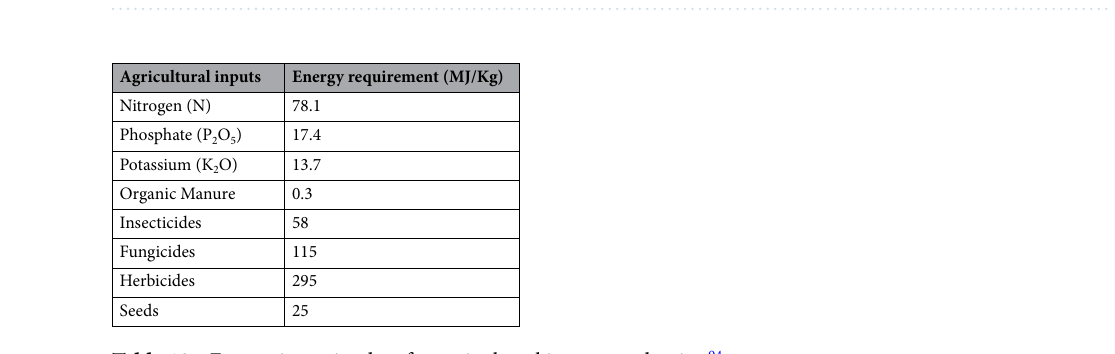
Table 18. Energy intensity data for agricultural inputs production 94